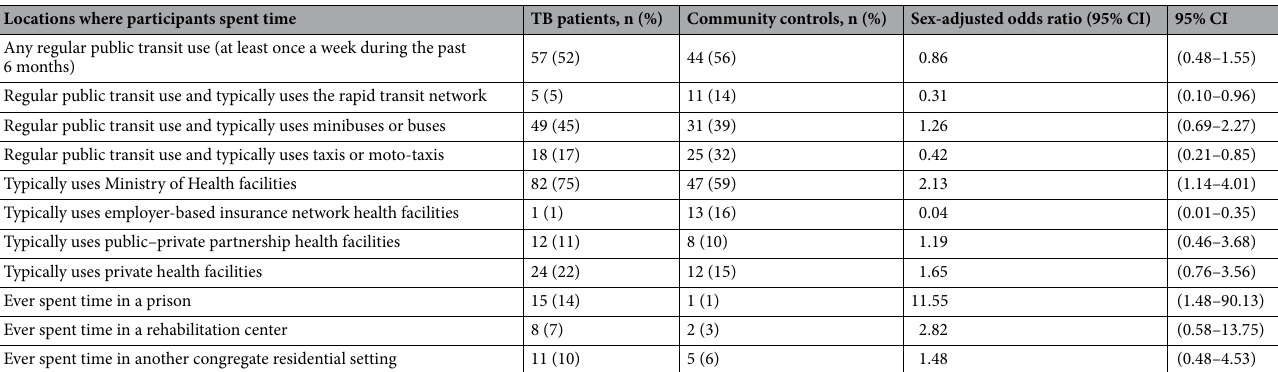
Table 2. Usage of public transit, health facilities, and congregate residential locations by pulmonary TB patients (N = 109) and community control group participants (N =